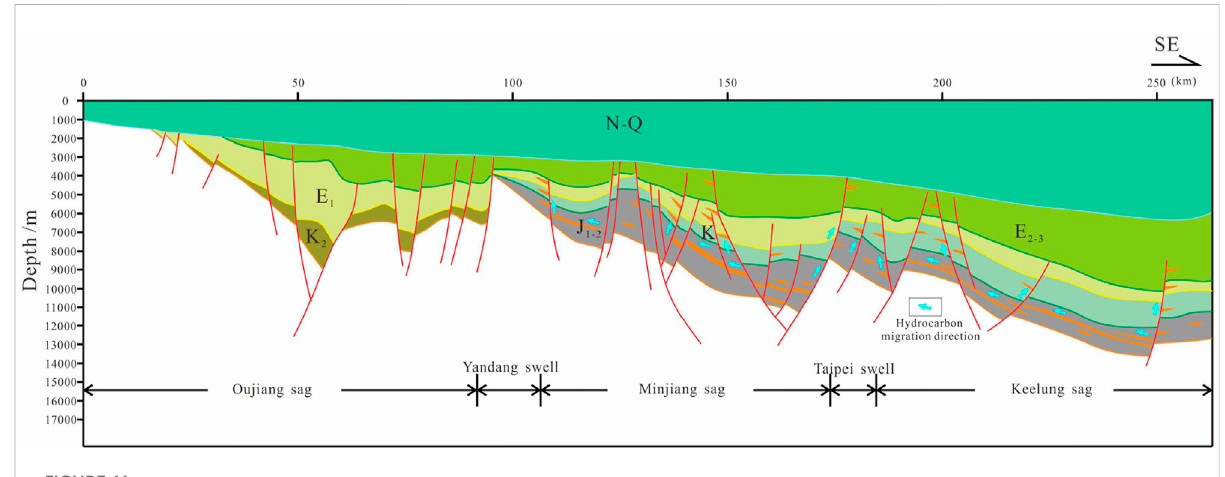
Favorable Jurassic oil-gas accumulation models in the SECS (location of the Section C is shown in Figure 1). The fi ll colors represent different strata. The J 1-2 label represents the Early – Middle Jurassic; J 3 -K represents the Late Jurassic – Cretaceous; K 2 represents the Late Cretaceous; E 1 represents the Paleocene; E 2-3 represents the Eocene – Oligocene; and N-Q represents the Neogene –